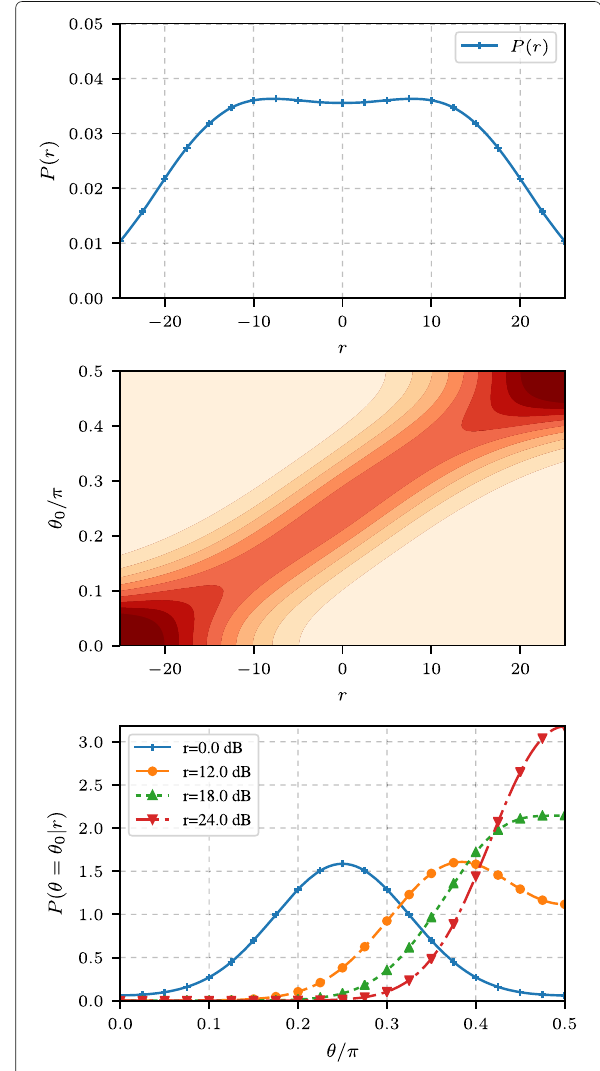
Fig. 6 Densities: marginal likelihood ( a ) and posterior density ( b , c